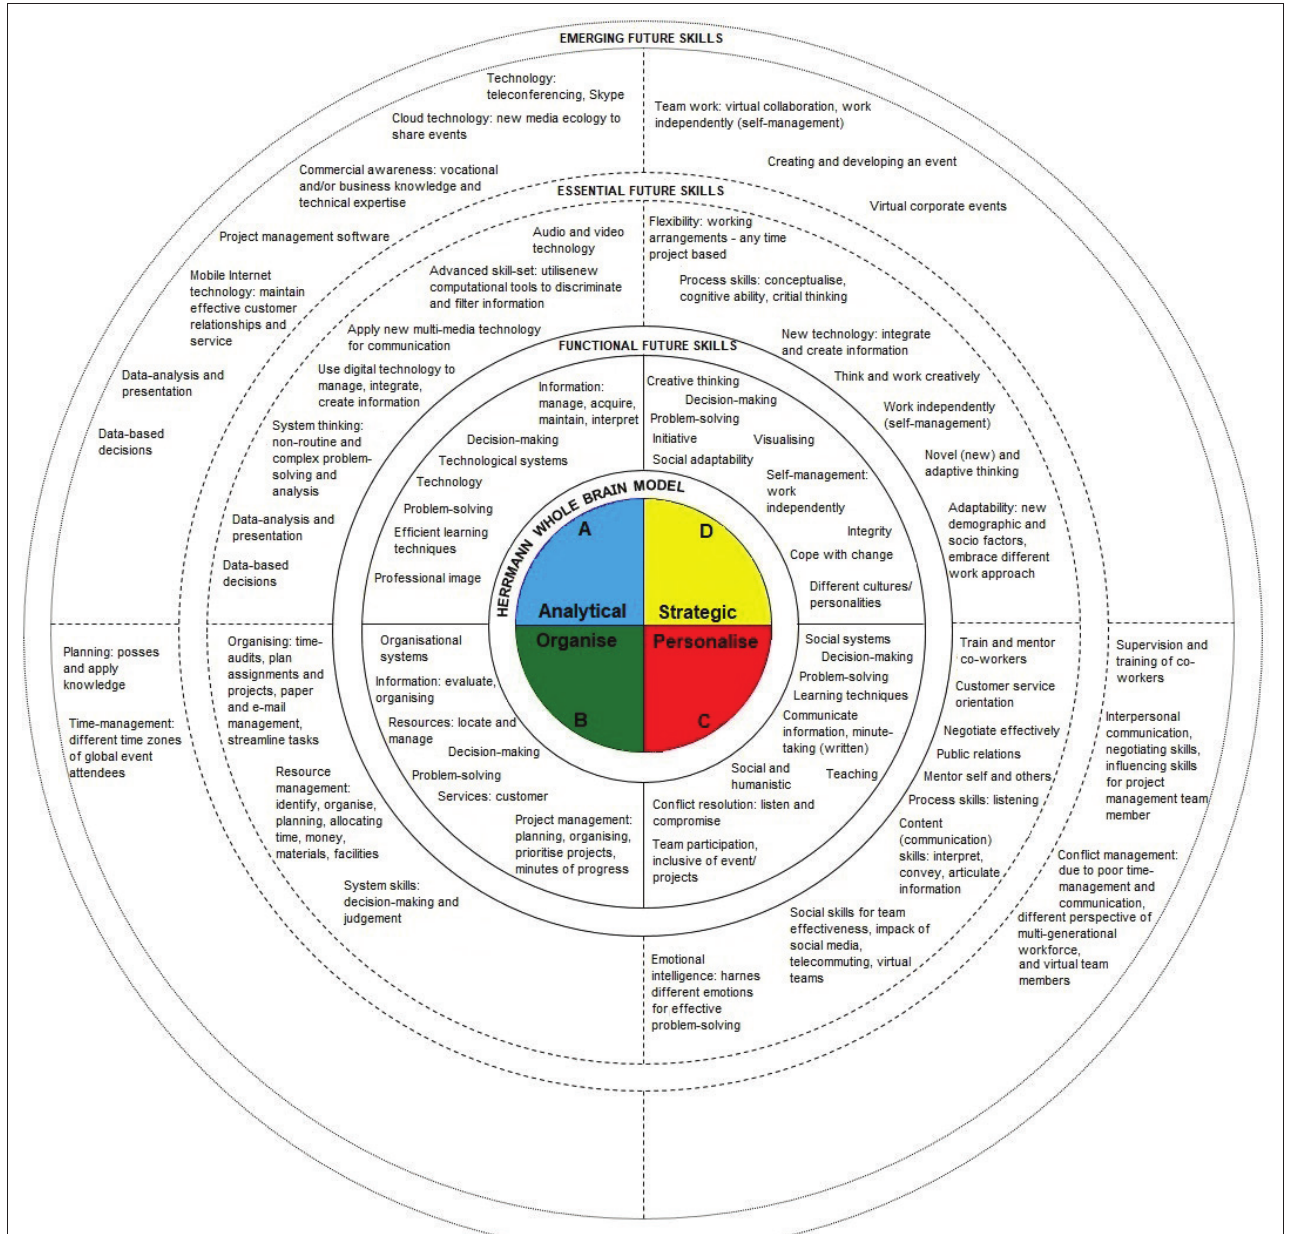
FIG URE 4: Future-focused whole-brain